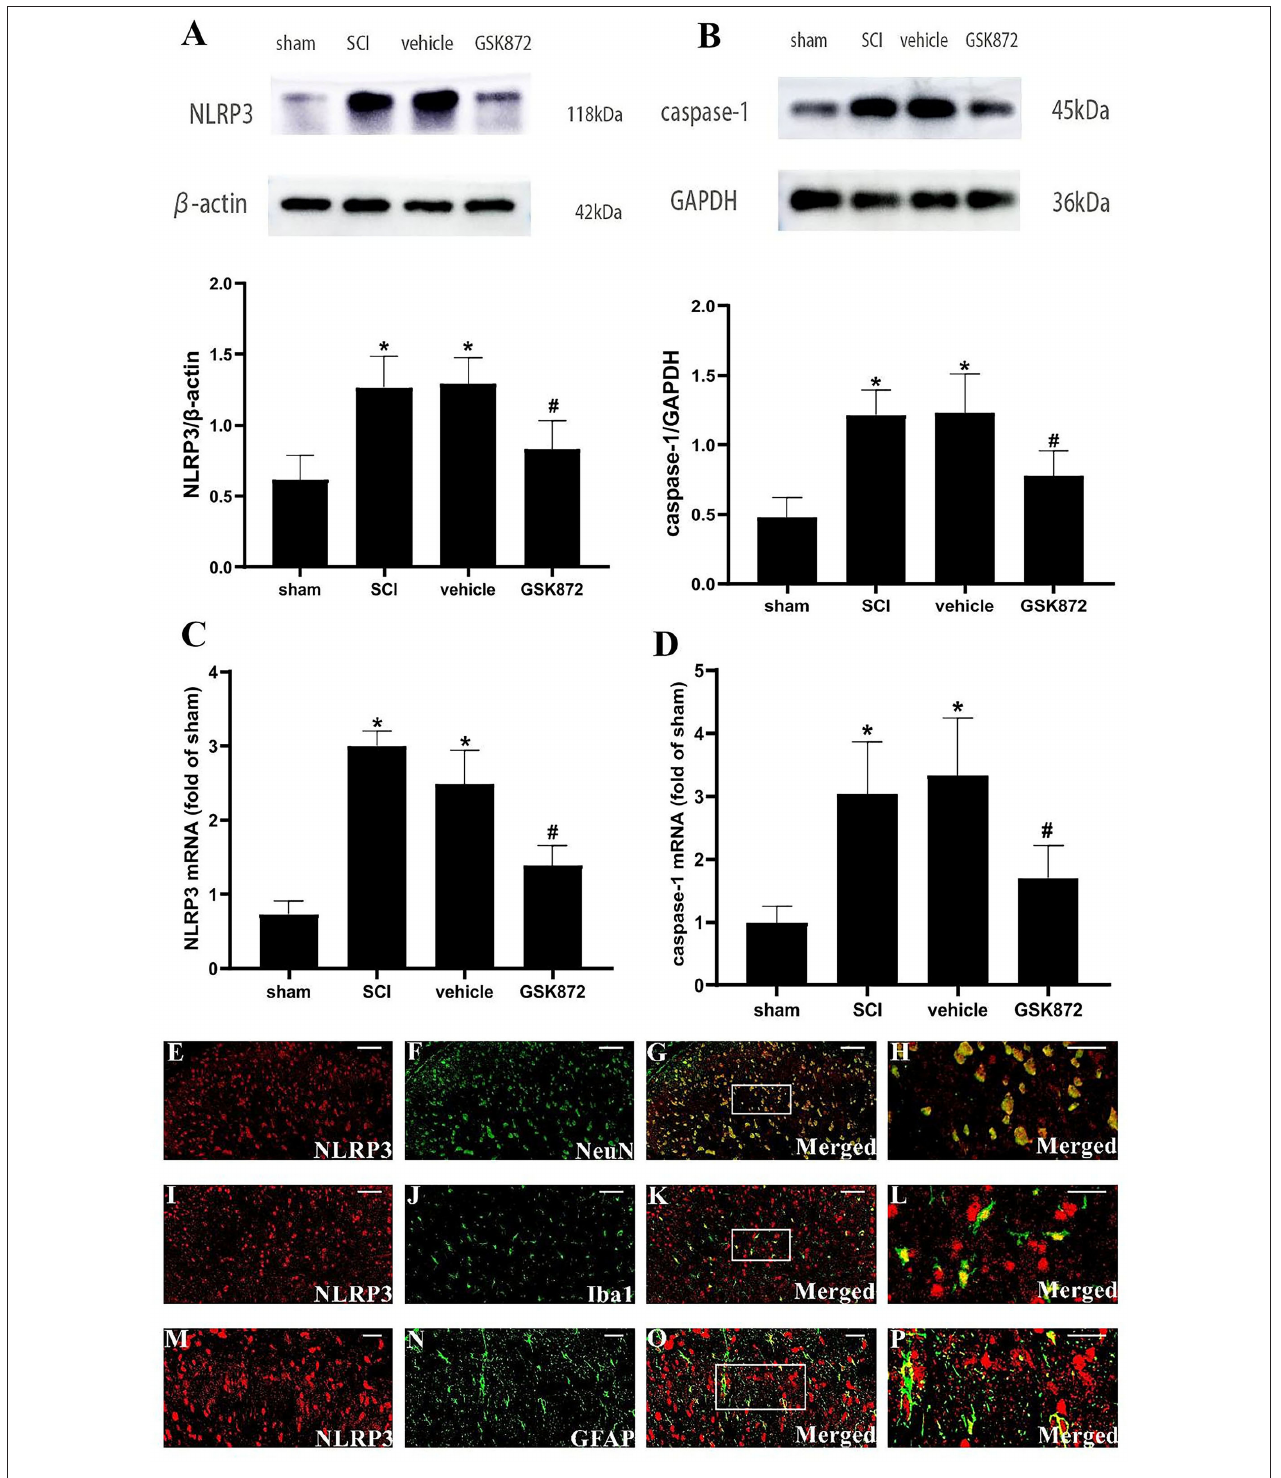
FIGURE 5 | GSK872 (10 µ l, 25 mmol/L) suppressed the activation of NLRP3 inflammasome in glia and neurons. (A,B) The expressions of NLRP3 and caspase-1 in different groups, including sham, SCI, vehicle and GSK872 group, were measured by western blot analysis ( n = 5 for each group). (C,D) Quantitative analysis of NLRP3 and caspase-1 mRNA expressions in different groups including sham, SCI, vehicle and GSK872 group ( n = 4 for each group). (E–P) Immunofluorescence staining of NLRP3 (red) with NeuN, a neuronal marker (green); GFAP, an astrocyte marker (green); and Iba-1, a microglial marker (green) in the lumbar dorsal horns of SCI rats. Scale bar, 50 µ m (E–G,I–K) . Scale bar, 25 µ m (M–O) . Scale bar, 20 µ m (H,L,P) . All data were calculated as mean ± SD. * p < 0.05 vs. the sham group. # p < 0.05 vs. the vehicle group. Comparisons between multiple groups were carried out by one-way ANOVA and Turkey’s post-hoc